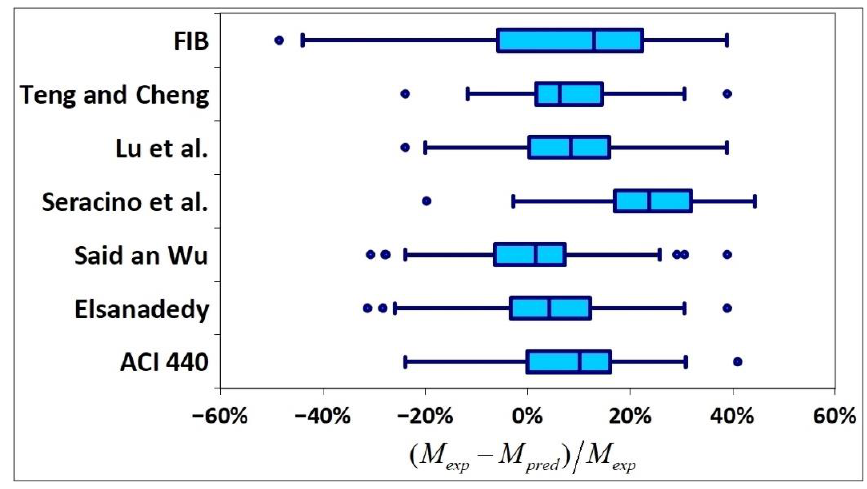
Figure 10. Measured flexural strength versus ACI 440 prediction.